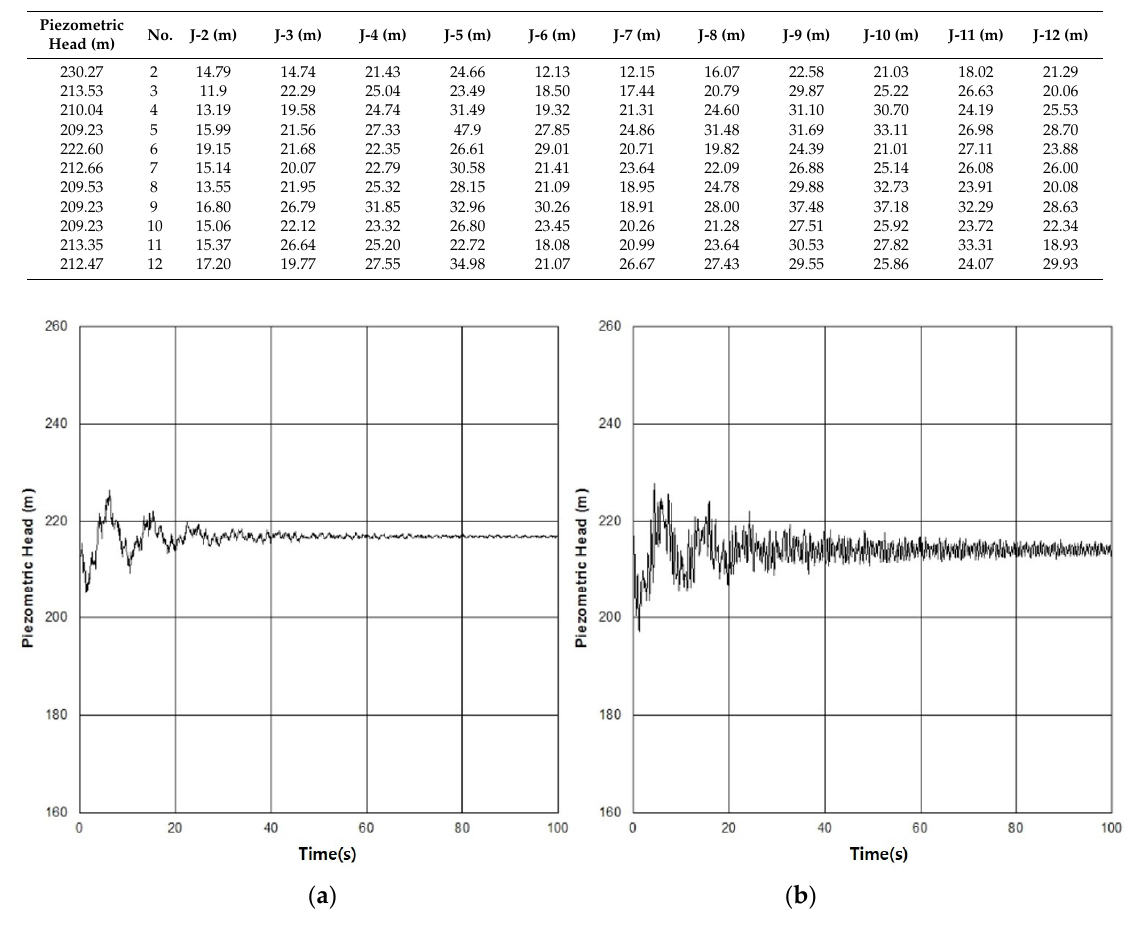
Table 8. Results of sensitivity analysis using the results of unsteady analysis. Rank 2 Table 9. Results of pressure contribution analysis using the results of unsteady analysis. Rank